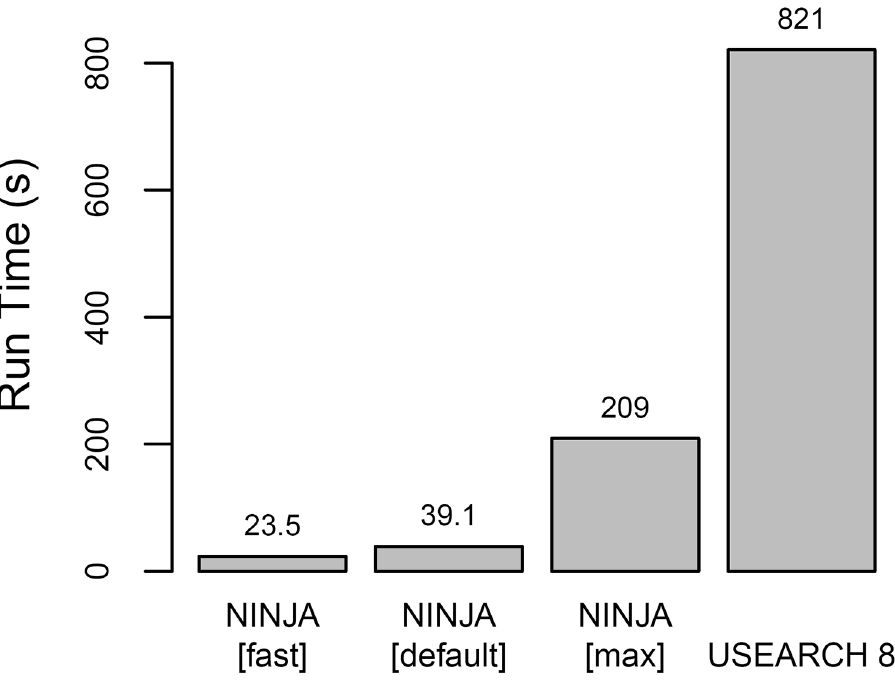
Fig 2. Benchmark of runtimes for NINJA compared to USEARCH 8 in a single-threaded environment. Multi-threaded alignments are faster. For NINJA only, this represents the entire time from parsing the initial FASTA file to the completion of the OTU table. The sortMeRNA program took substantially longer than USEARCH 8 (approx. 8000s; bar not shown to preserve scale).